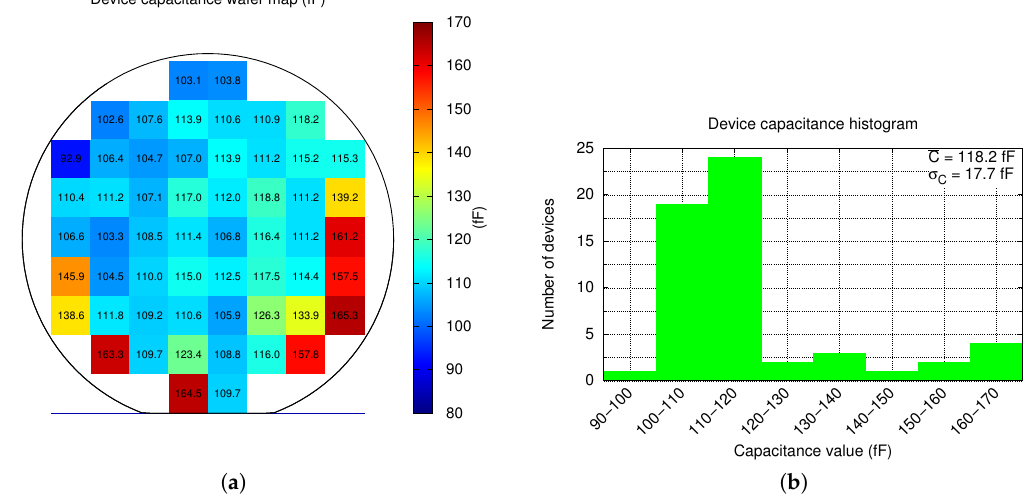
Figure 8. Wafer level measurements of device capacitance with 0 V wafer distribution ( a ), and the histogram ( b